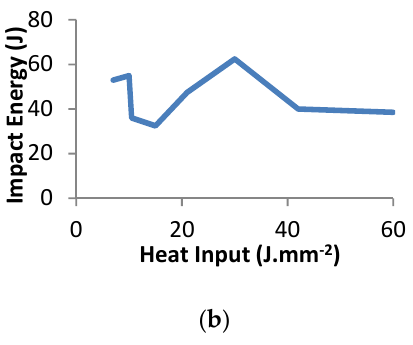
Figure 15. The impact energy profiles of CHT and LHT samples, ( a ) impact energy vs. laser powers and laser scanning speeds ; ( b ) impact energy vs. heat input.